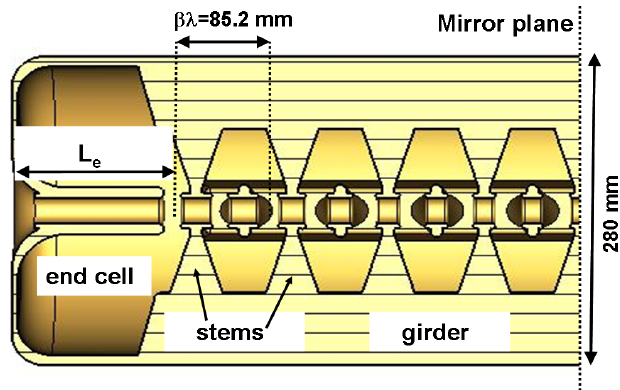
FIG. 6. (Color) Simulated influence of the girder height on the electric and magnetic peak